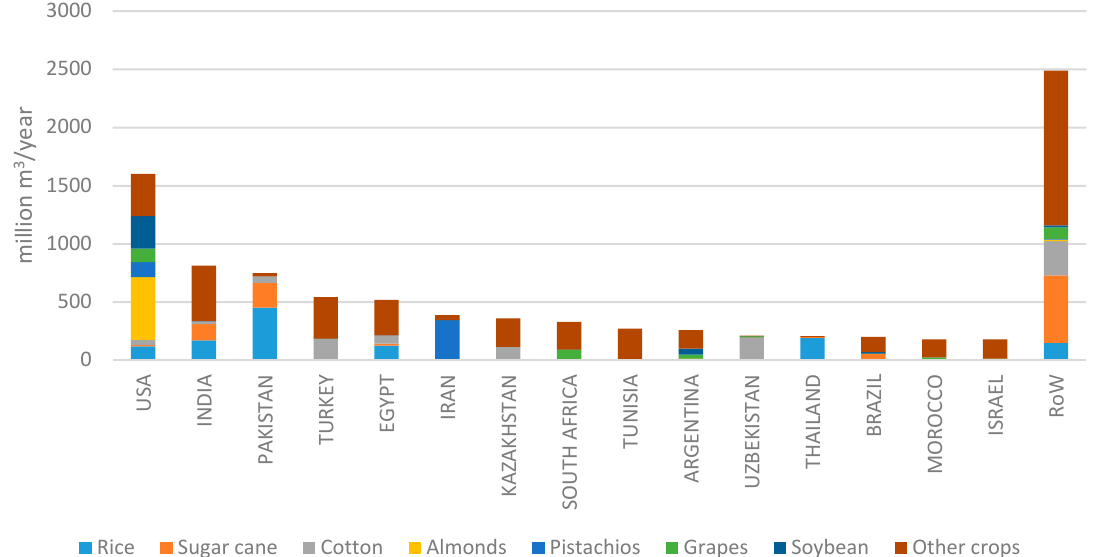
Figure 5. Blue virtual water imports to the EU per country, per crop product group (million m 3 /year).